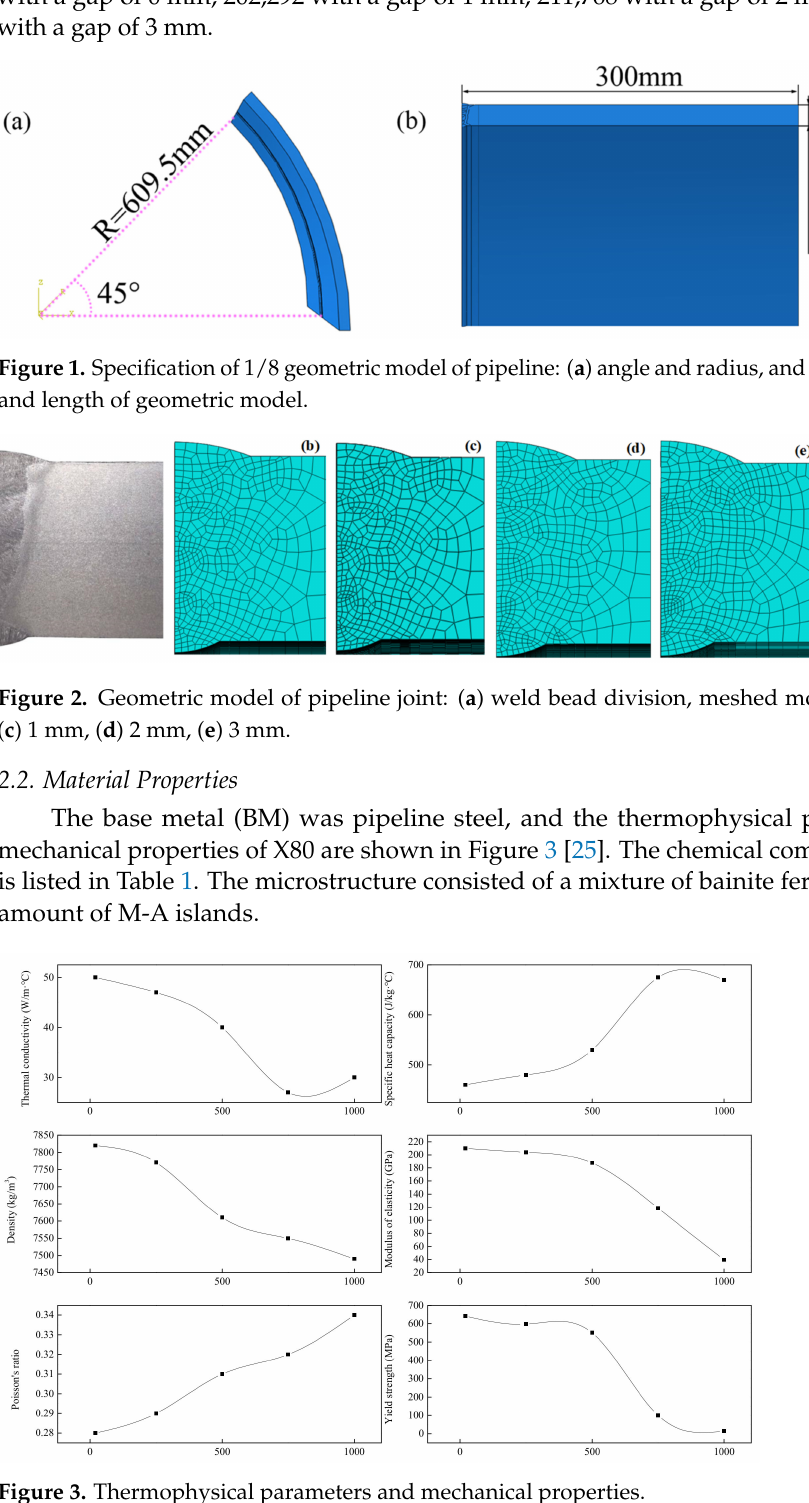
Figure 3. Thermophysical parameters and mechanical